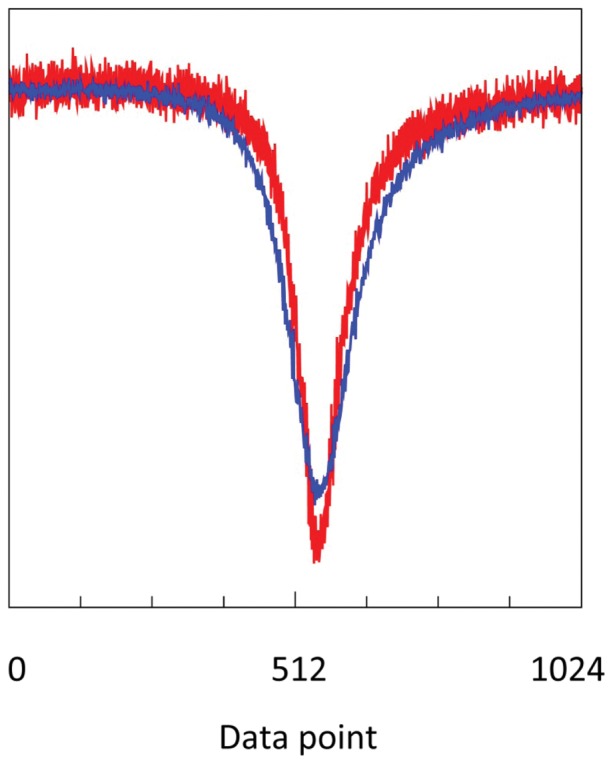
Rapid-scan transmission EPR to improve signal-to-noise ratio.A thick outer wall 40 cm cell was filled with solid DPPH, and a 2.7 GHz single-scan spectrum was taken in 30 s over a 959±20 gauss field range using a low-intensity microwave of −60 dBm incident power from the VNA to the amplifier to produce a spectrum with visible noise (red trace). Then a second spectrum was taken with the field at 959±0 gauss but with the field modulation unit set to 35 Hz and with a nominal peak-to-peak modulation amplitude of 40 gauss. The resulting data were mapped with a dedicated LabVIEW program to a sinusoidallly varying field and then interpolated to a 1024 point spectrum (blue trace). The increased width of the blue trace shows that the actual modulation amplitude felt short of 40 gauss, which illustrated that this experiment can be used as a convenient way to calibrate modulation coils. The rapid-scan EPR blue trace has reduced signal-to-noise (see text for details).